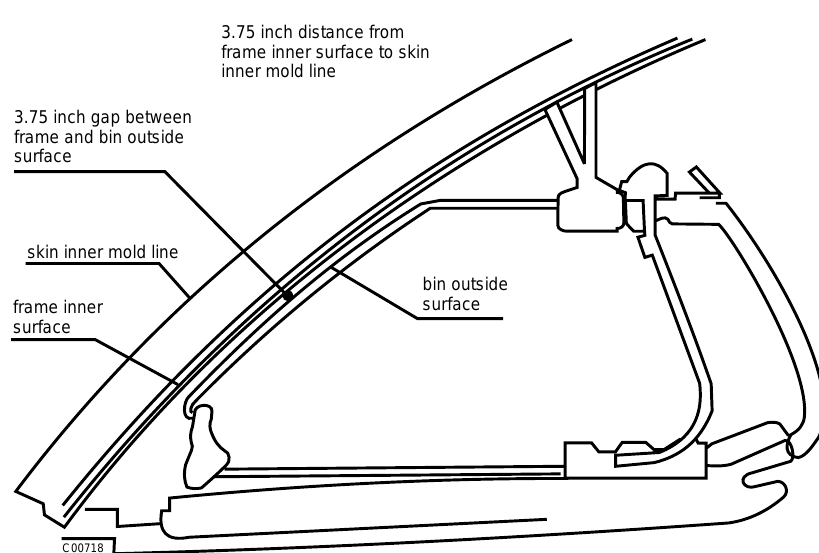
Fig. 2. Boeing 737 overhead bin